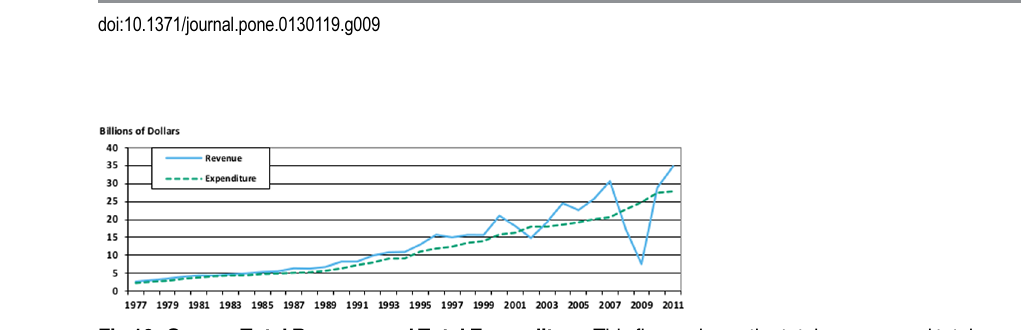
Fig 10. Oregon Total Revenue and Total Expenditure. This figure shows the total revenue and total expenditure of Oregon State government over